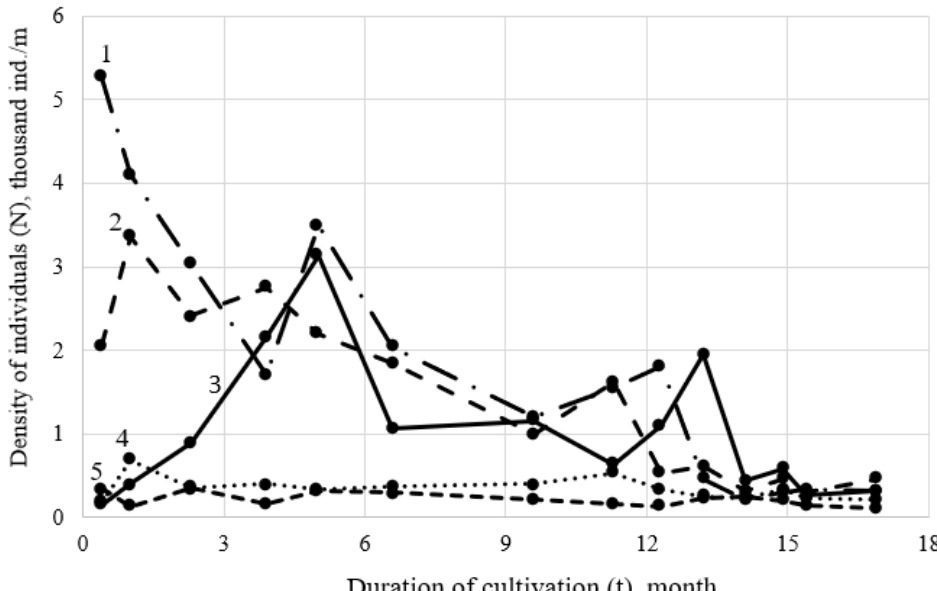
Figure 1. Changes in the density of mollusks (N, thousand ind./m) during the cultivation of mussels (t, month) on the 1st type of collectors (ω = 0.09). The starting point on the abscissa is May of the current year Each curve is one cycle of mussel growing (hereinafter, the starting point on the abscissa is May)